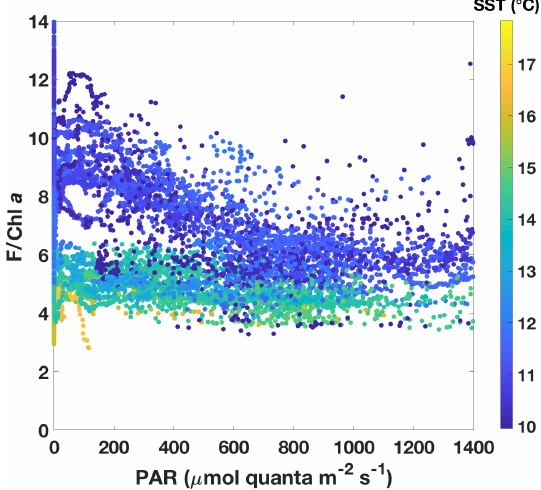
Figure 7. Underway fluorescence data normalized to Chl a plotted against incident PAR above the surface. Chl a was estimated from ac-9 data. Data points are colour-coded according to